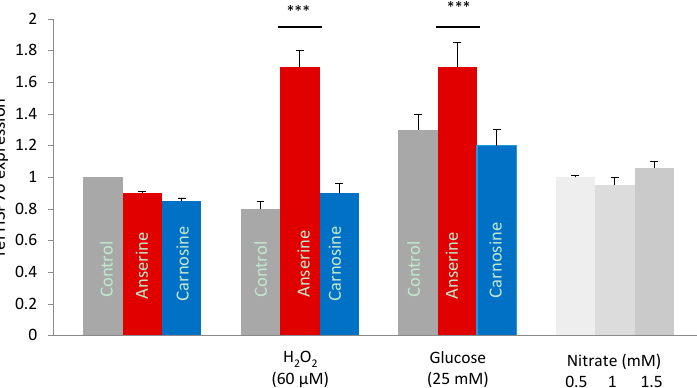
Figure 3. Effect of anserine and carnosine in human tubular cells exposed to oxidative and glycative stress. Human tubular cells (HK-2) were stressed by H 2 O 2 (60 µM) and glucose (25 mM) and co-incubated with 1 mM anserine (red bars) and carnosine (blue bars), respectively, compared to control (grey bars). Cellular heat shock protein 70 (Hsp70) mRNA was measured by RT-PCR and normalized to expression of β -actin. Hsp70 expression significantly increased with co-incubation of anserine but not with carnosine. Since a nitrated form of anserine was applied, an independent effect of nitrate (green bars) on Hsp70 was ruled out. p < 0.01 (**); p < 0.001 (***).